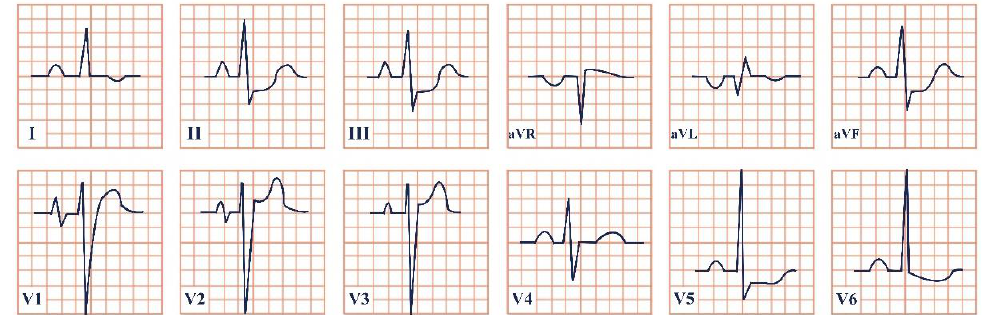
Figure 13. Electrocardiogram aspect in LEOPARD syndrome.